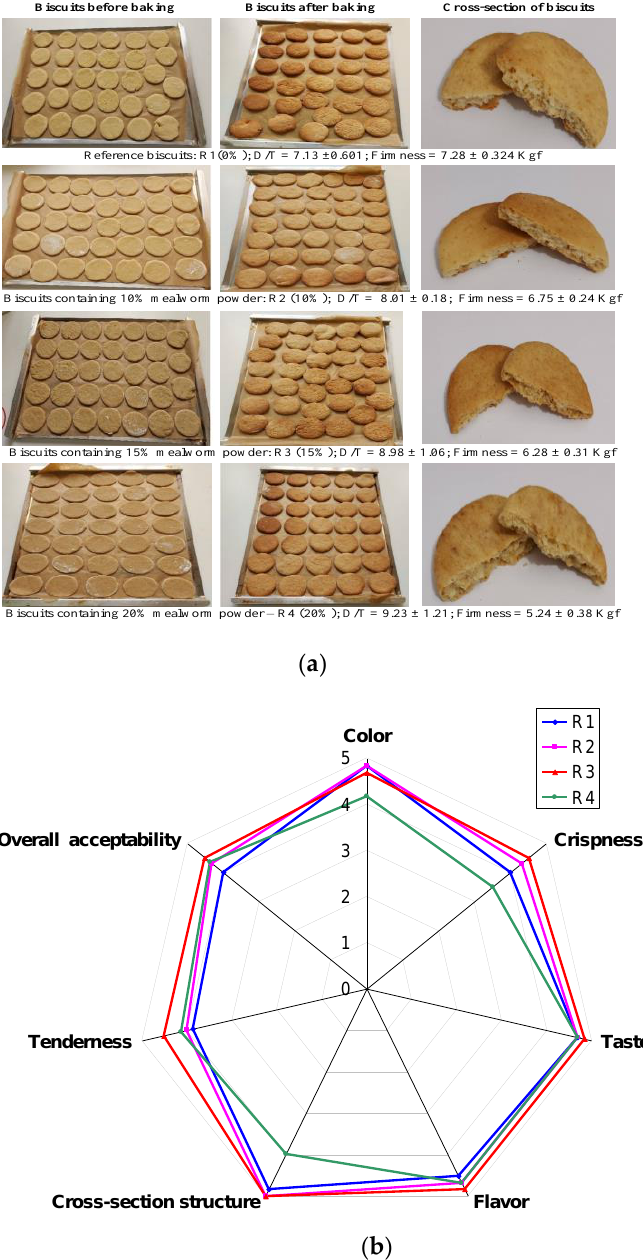
Figure 1. Appearance of prepared biscuits ( a ) and the results of their sensorial analysis ( b ): R1 — reference biscuits; R2 — biscuits with 10% yellow mealworm powder; R3 — biscuits with 15% yellow mealworm powder; R4 — biscuits with 20% yellow mealworm powder. The water-soluble amino acid profiles (Table 4) indicated a higher level of essential amino acids EAAs of 50.31% in the R3 biscuits compared to 45.07% in R1 biscuits. Regarding EAAs, a larger percentage of valine was found in R3 than in R1, while the nonessential amino acids (NEAAs) proline, glutamic acid, and asparagine prevailed in